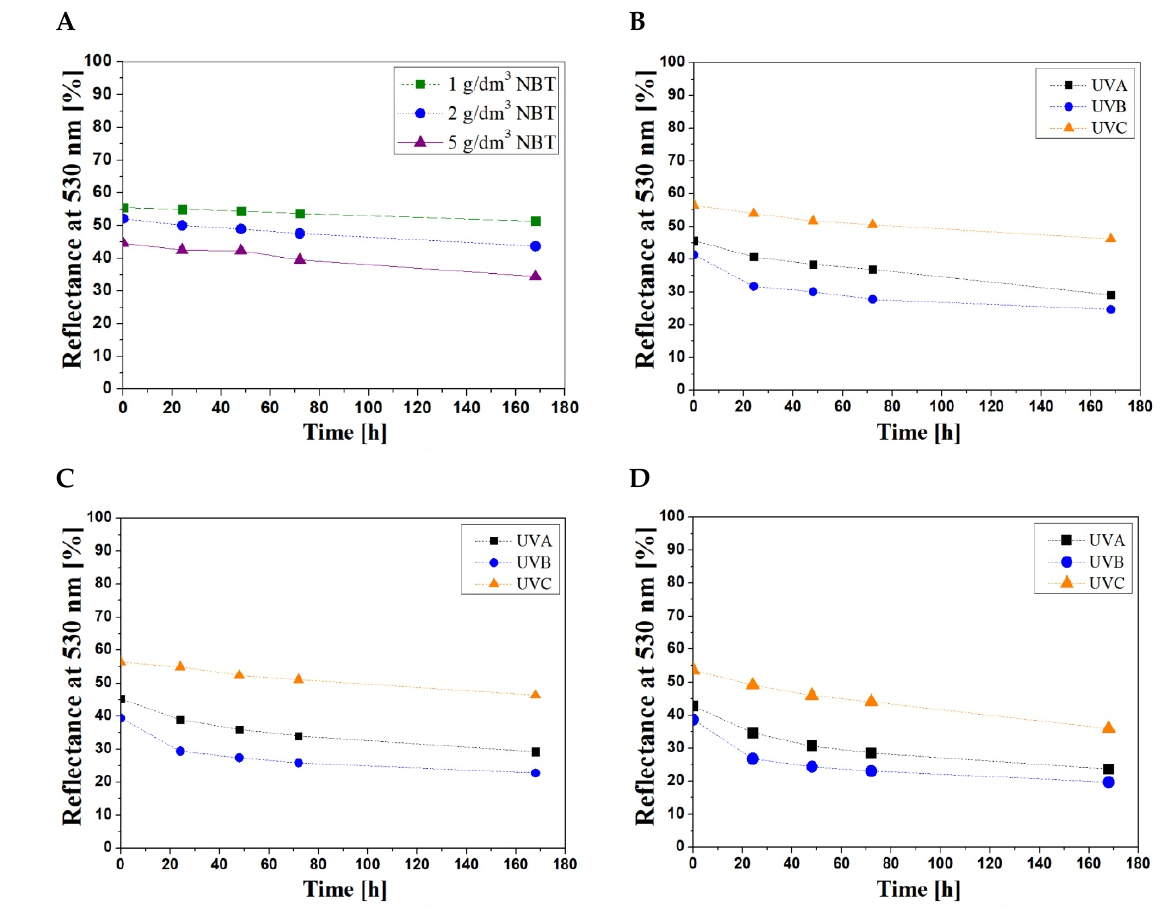
Figure 2. The stability of non-irradiated NBT–Pluronic F–127 samples ( A ) and irradiated samples (1 J/cm 2 ) of various NBT concentrations: 1 g/dm 3 ( B ), 2 g/dm 3 ( C ) and 5 g/dm 3 ( D ). Table 3. The percent changes in the light reflectance at 530 nm for NBT–Pluronic F–127 samples irradiated with 1 J/cm 2 during 0 ‒ 168 h of storage.